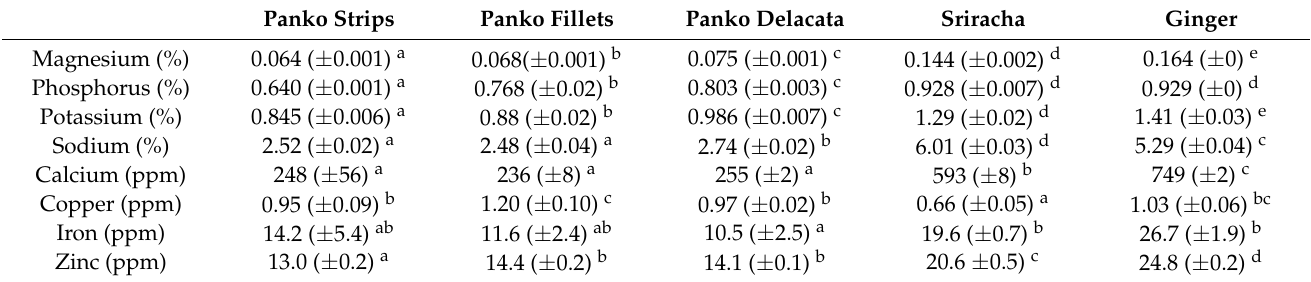
Table 3. Mineral